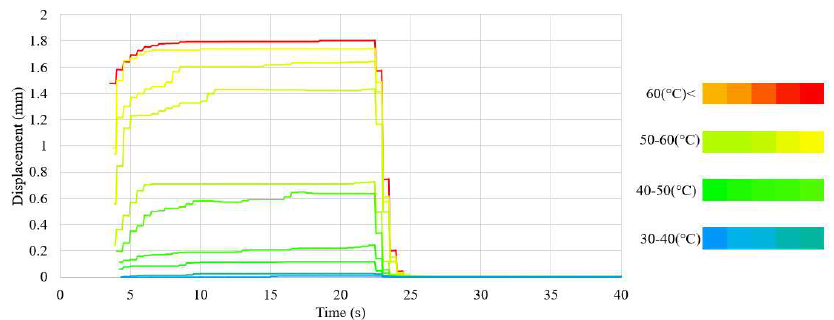
Figure 9. Waveform of the force in relation to the average temperature during heating (test sample, diameter 150 μm).